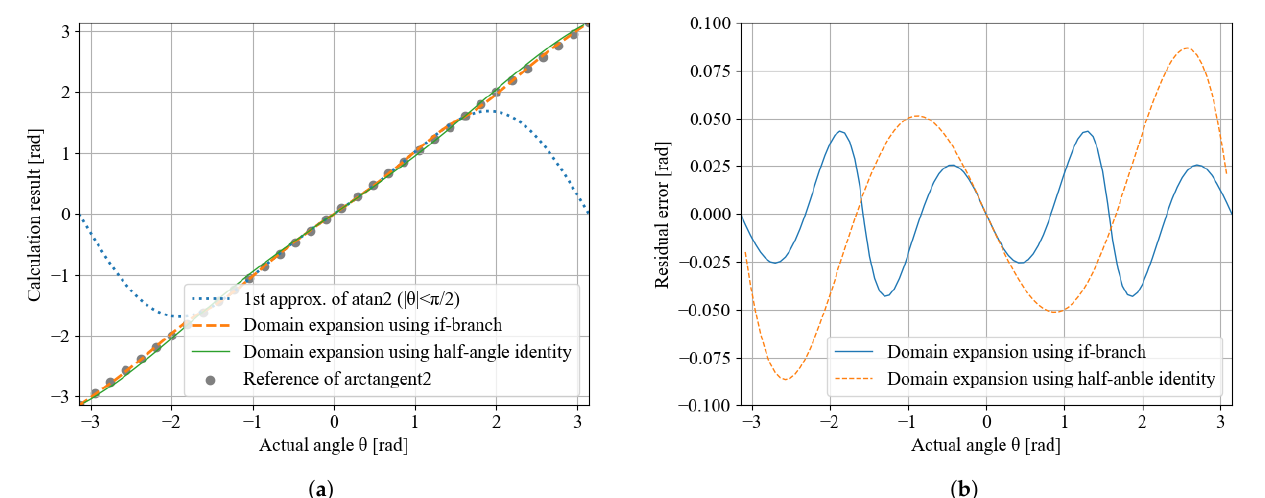
Figure 5. First approximation of atan2 and its domain expansion (plot using x = cos θ , y = sin θ ). ( a ) First approximation of atan2 and domain expansion. ( b ) Residual error in each